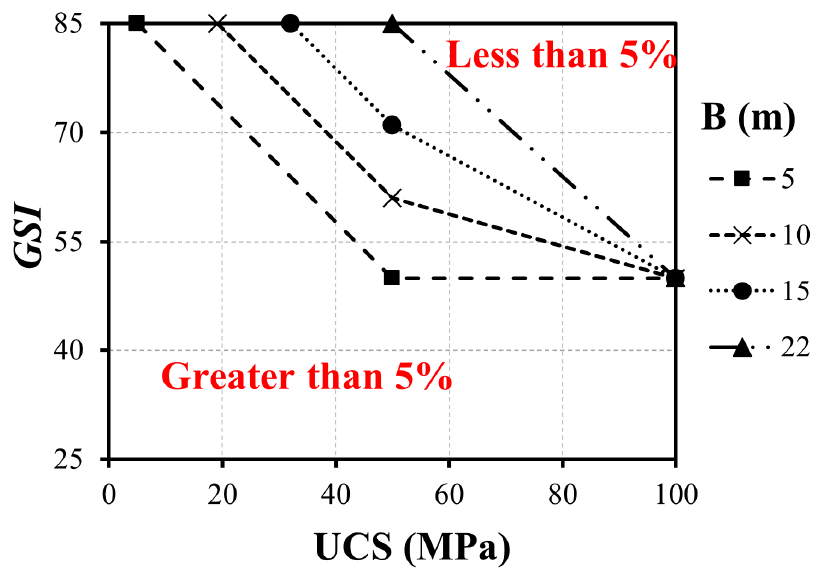
Figure 15. Limit of 5% increase in the bearing capacity due to the self-weight of the material.